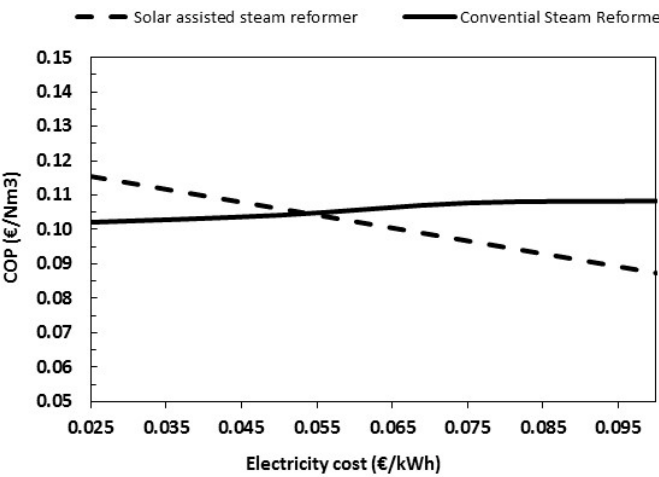
Figure 12. Influence of COP vs electricity cost.